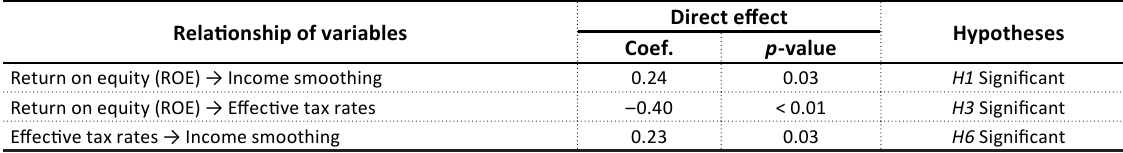
Table 4. Hypotheses testing results of indirect effects